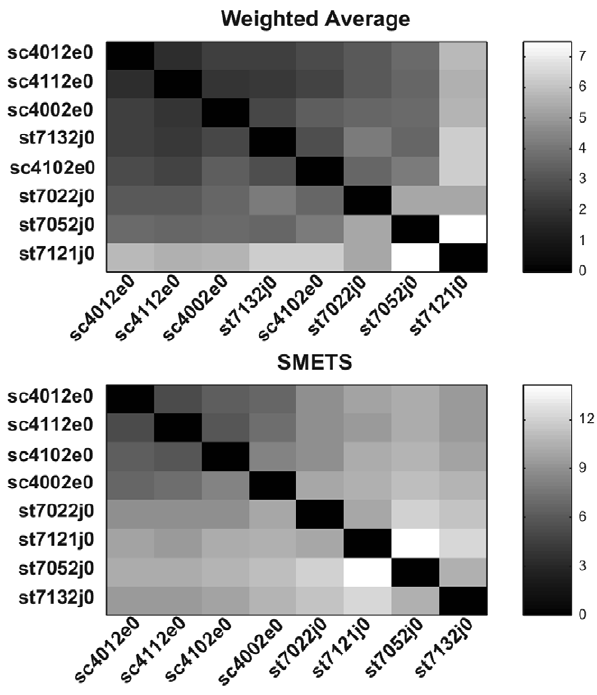
Figure 11. Distance matrices unmodified electrophysiological sleep data. Distance values were measured using the average and SMETS distances and are encoded in grayscale.